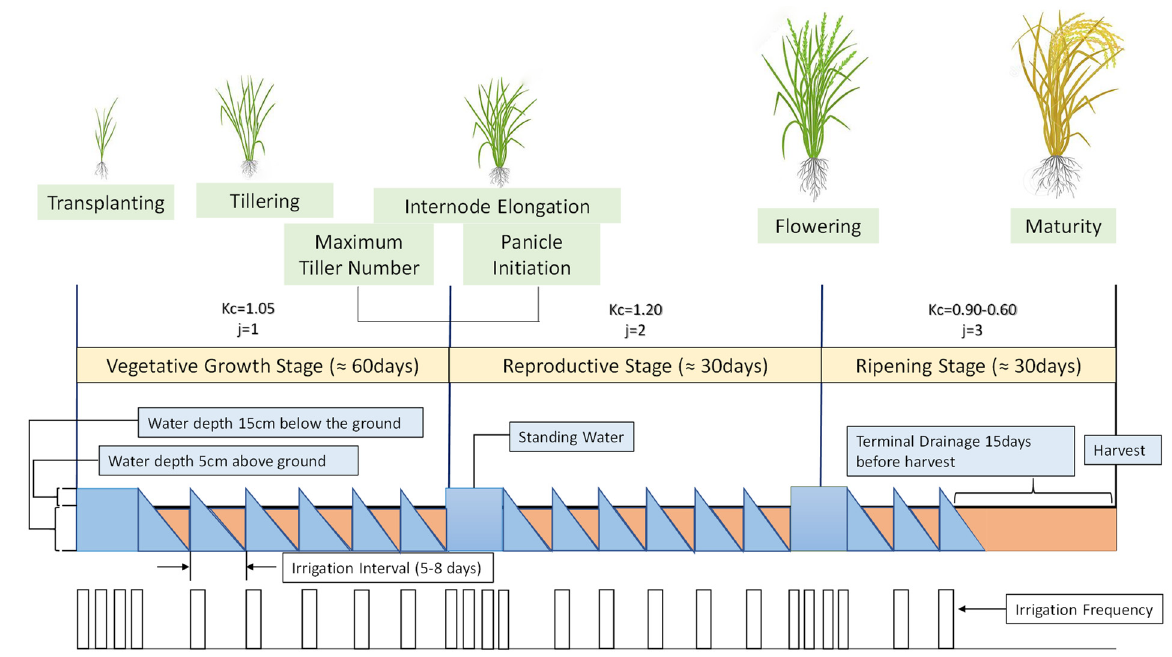
Figure 4. Irrigation scheduling in alternate wetting and drying (AWD) irrigation method.